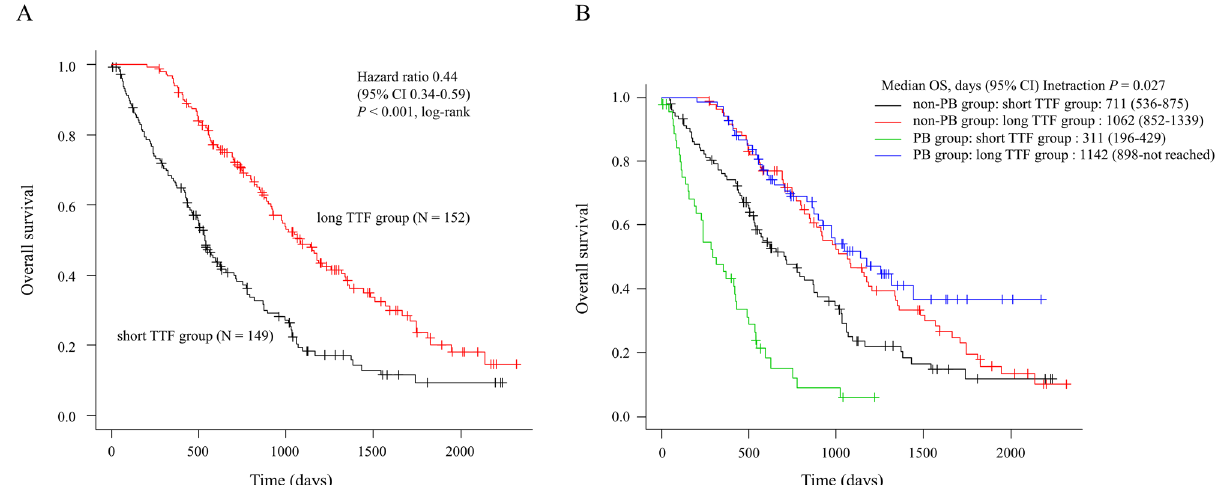
Figure 1. Overall survival according to the duration of first-line time to treatment failure ( A ) and overall survival based on the duration of first-line time to treatment failure and first-line chemotherapy regimens ( B ). CI , confidence interval, HR hazard ratio, PB paclitaxel plus bevacizumab, TTF time to treatment failure.